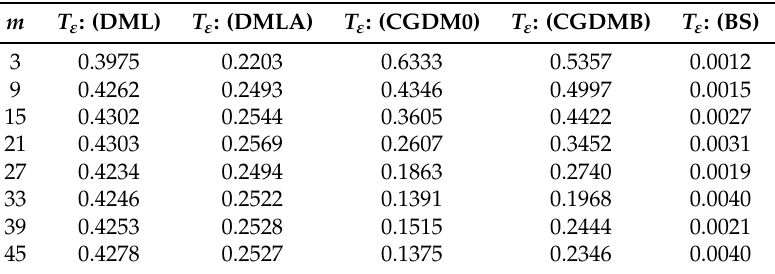
Table 18. Results for Case LG with J = 510, ε = 10 − 2